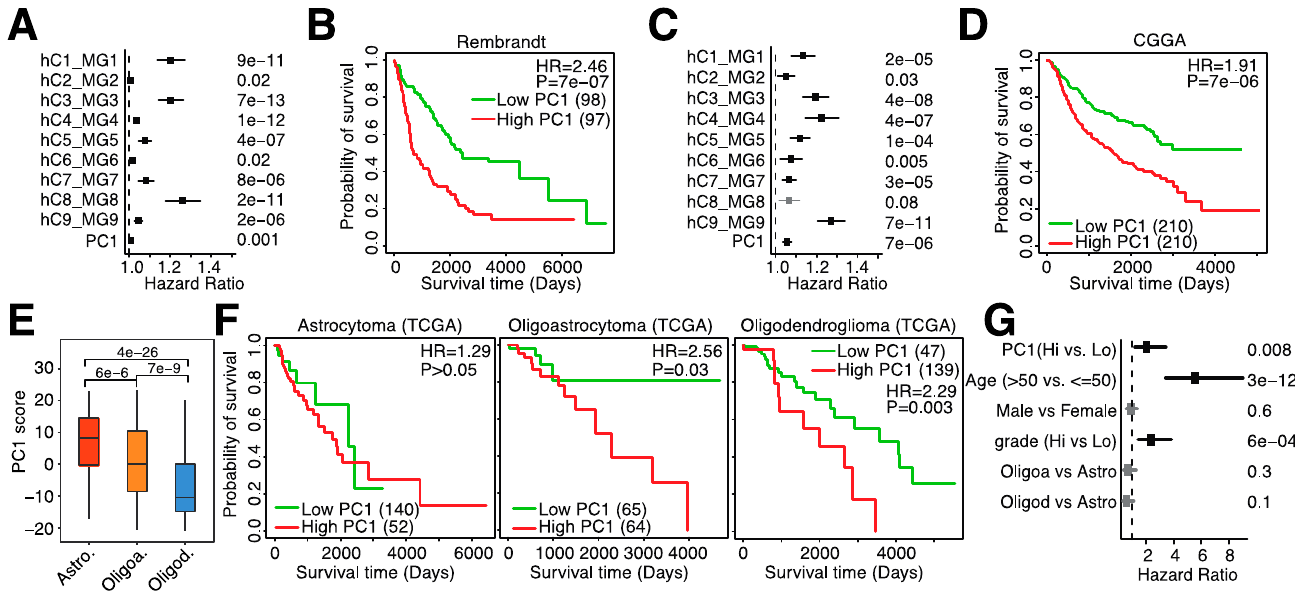
Figure 4. Microglia abundance is negatively associated with prognosis in independent datasets and subtypes of low-grade glioma. ( A ). Hazard ratios of univariate Cox regression models evaluating the association between overall survival and 9 human microglia signatures and PC1 in the Rembrandt dataset. ( B ). Kaplan–Meier plot depicting the association between overall survival and PC1 in the Rembrandt dataset. ( C ). Hazard ratios of univariate Cox regression models evaluating the association between overall survival and 9 human microglia signatures and PC1 in the CGGA dataset. ( D ). Kaplan–Meier plot depicting the association between overall survival and PC1 in the CGGA dataset (mRNAseq_693). ( E ). Boxplot comparing PC1 scores among glioma subtypes. Astro. = astrocytoma, Oligoa. = oligoastrocytoma and Oligod. = oligodendroglioma. ( F ). Kaplan– Meier plots depicting the association between overall survival and PC1 in different glioma subtypes in the TCGA dataset. ( G ). Forest plot depicting hazard ratios of univariate Cox regression models evaluating the association between overall survival and several clinical